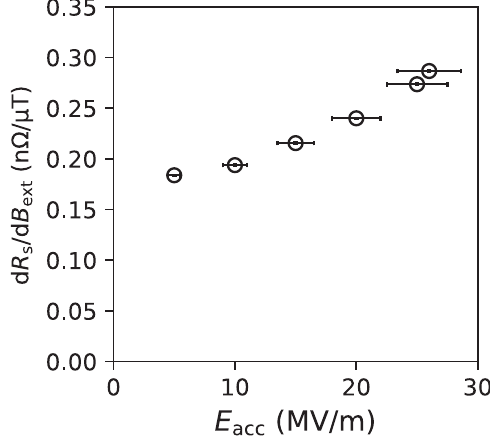
FIG. 15. Slope of surface resistance with applied magnetic field and accelerating